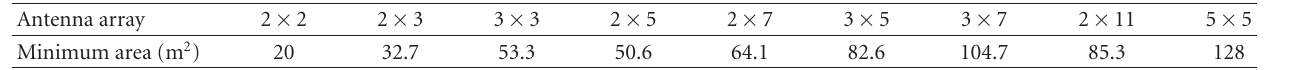
Table 1: Minimum array area for di ff erent configurations.